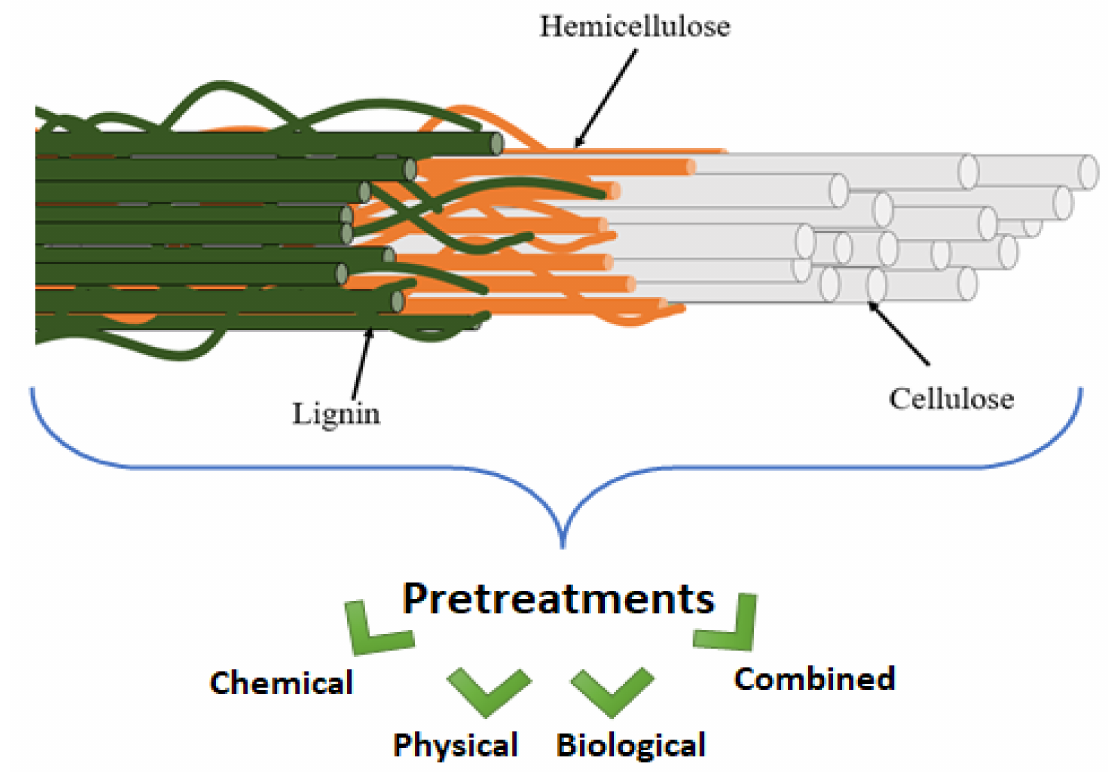
Figure 1. Overview of the complex structure of natural fibers and